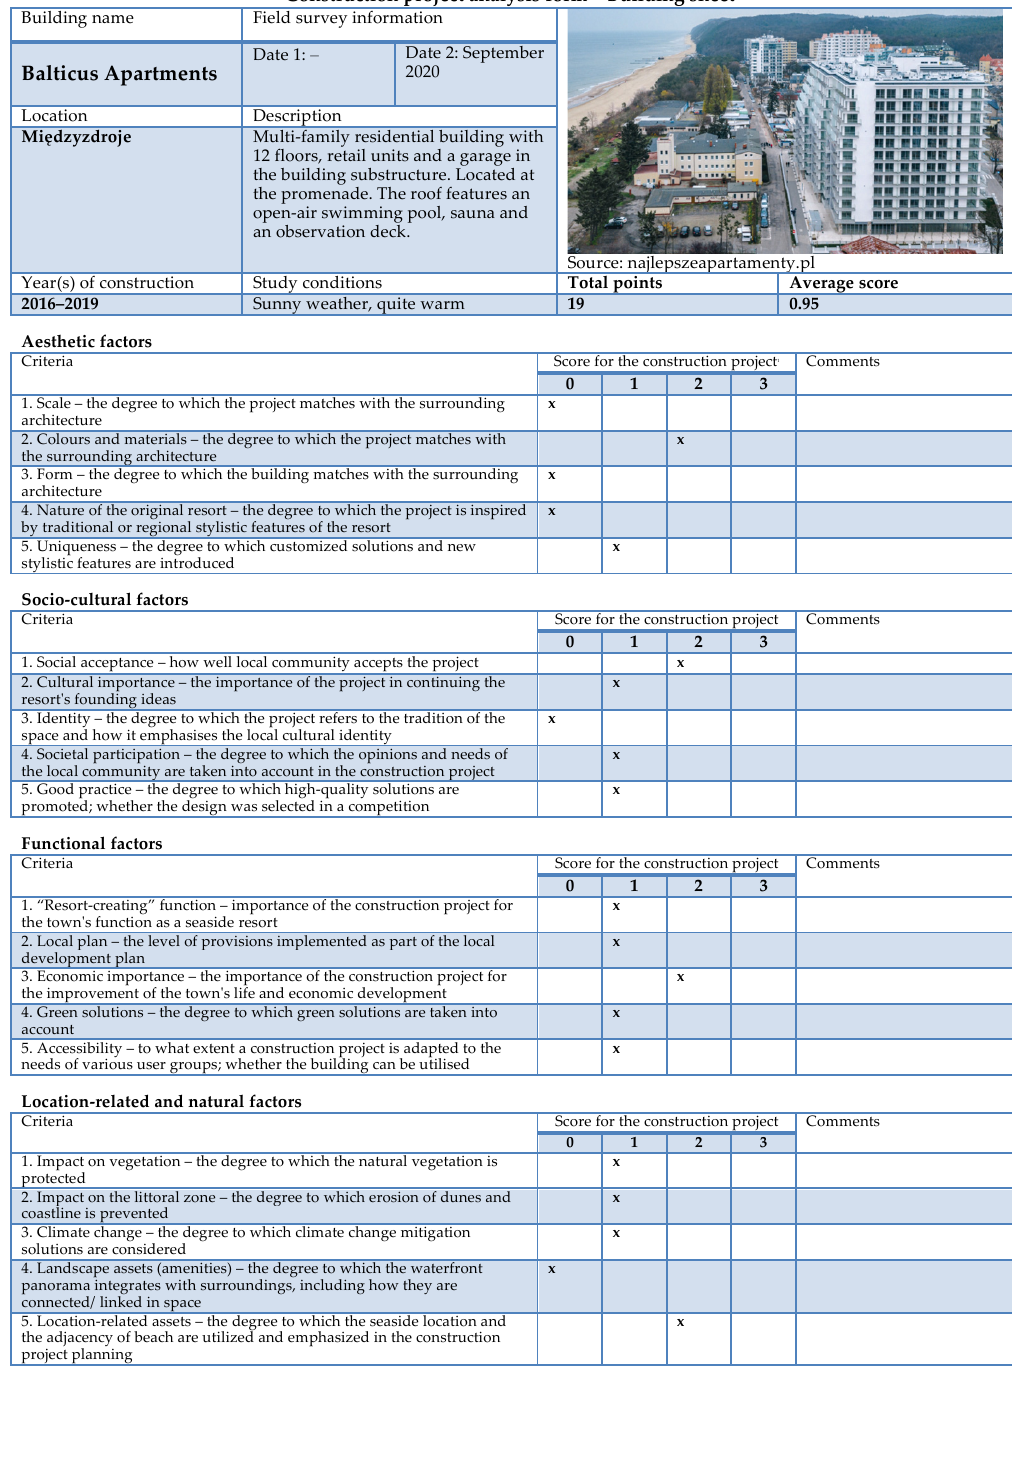
Figure A5. Balticus Apartments in Mi ę dzyzdroje. Building sheet.